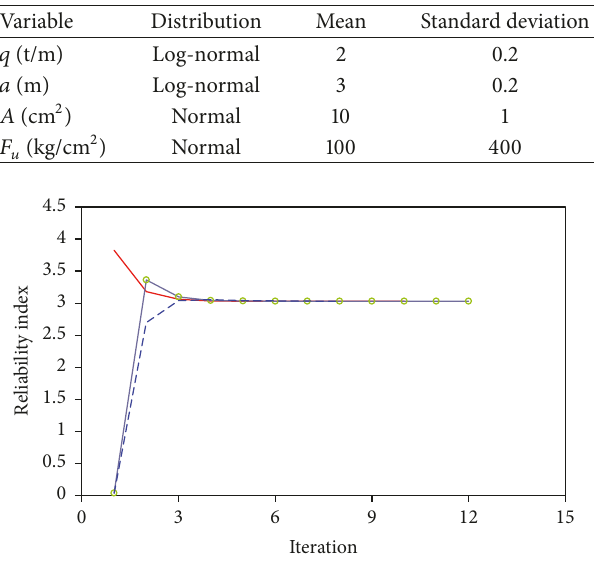
Table 1: Random variables for the bar example under tensile load.